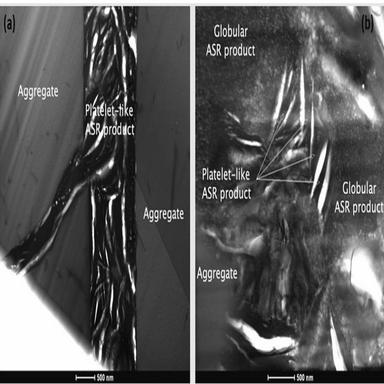
Field sample of a wall structure showing ASR morphologies: (a) platelet-like morphology and (b) intermix of both granular and platelet-like morphology. Image reproduced from.